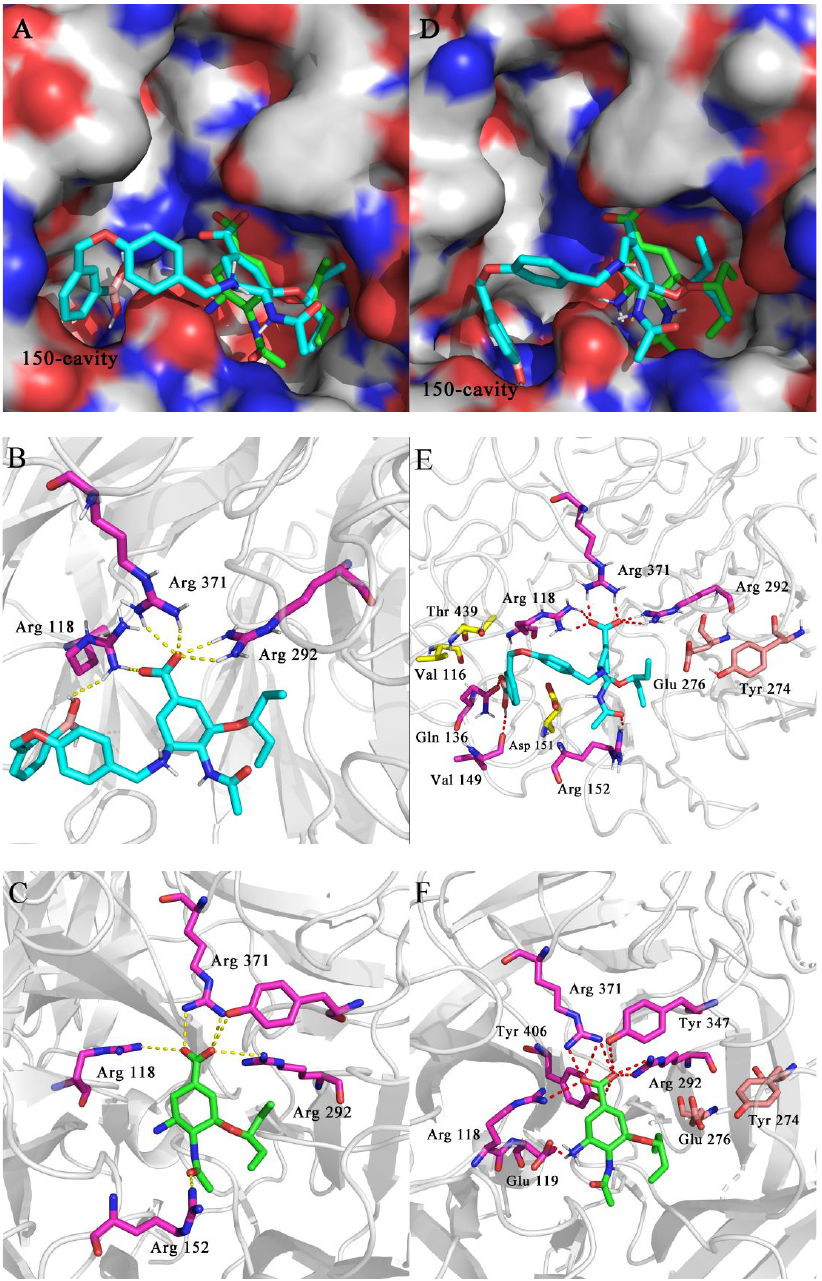
Figure 5. Putative binding models of 2c (cyan) and OSC (green) with the crystal structures of N1 (H5N1, PDB ID: 2HU0) and N1-H274Y (H5N1-H274Y, PDB ID: 3CL0). ( A , D ). Superposition of 2c and OSC with H5N1 NA and H5N1-H274Y NA, respectively; ( B , E ). The key interactions formed between 2c and H5N1 NA and H5N1-H274Y NA, respectively; ( C , F ). The key interactions formed between OSC and H5N1 NA and H5N1-H274Y NA, respectively. Hydrogen bonds are shown as dashed lines (yellow for H5N1 NA, red for